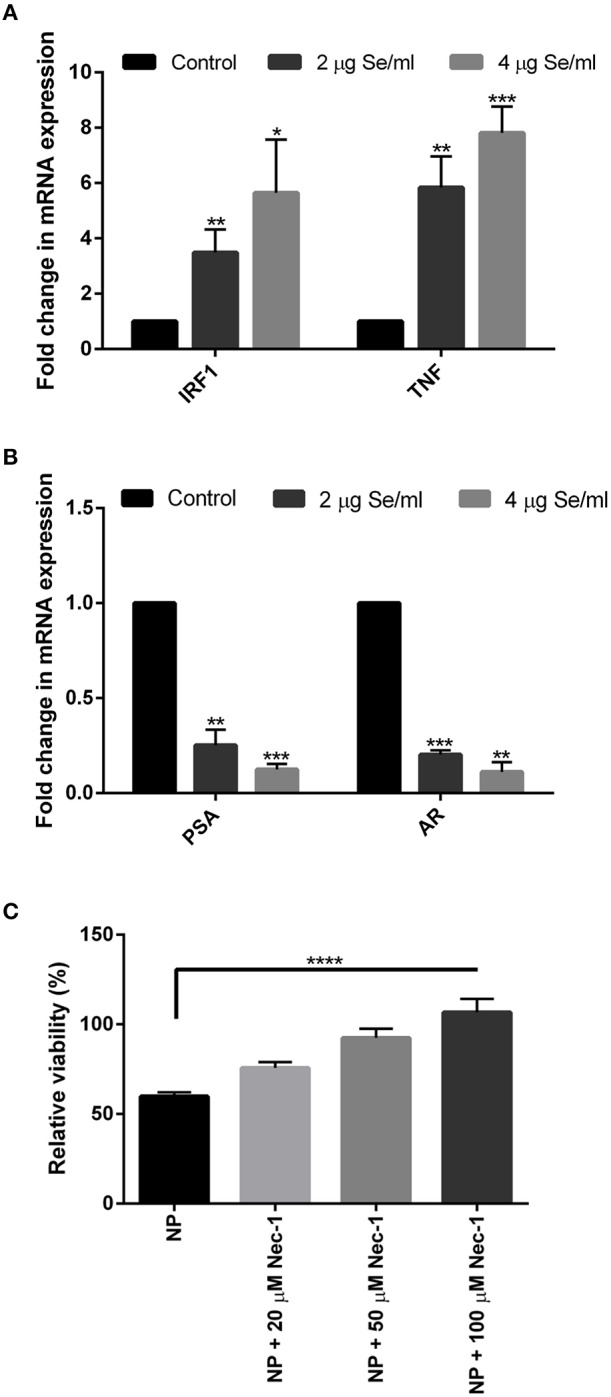
(A,B) Real-time gene expression profiling of SeNPs treated and untreated LNCaP cells was performed. Significant dose-dependent fold change (*p < 0.05, **p < 0.01, and ***p < 0.001) was observed in the expression of IRF1, TNF, PSA, and AR gene in LNCaP cells on SeNP treatment. The experiment was conducted in triplicate. (C) LNCaP cells were cultured in the presence of 2 μg Se/ml SeNPs along with 20, 50, or 100 μM Necrostatin-1 for 24 h. Cell viability determined with MTT assay showed more viable cells in wells treated with SeNP along with Necrostatin-1 compared to SeNP treated cells. Cell viability was directly proportional to the concentration of Necrostatin-1 used. The results were confirmed by three repetitions of experiments and each experiment was conducted in triplicate. ****p < 0.0001 represents a significant difference in the viability of LNCaP cell treated with SeNP or SeNP with 100 μM Necrostatin-1.